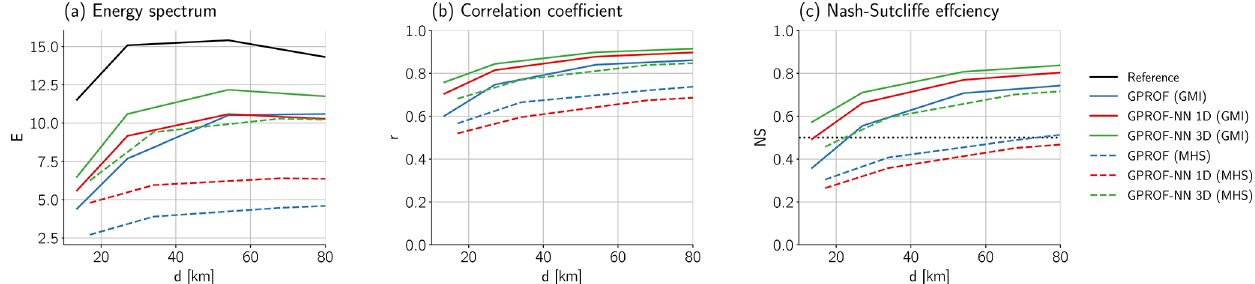
Figure 10. Spatial variability of retrieved and reference fields. Panel (a) shows the average of the total energy defined as the sum of the squared wavelet coefficients at different length scales for the reference and retrieved surface precipitation fields. Panel (b) shows the correlation coefficient between the coefficients of the reference and the retrieved precipitation field. Panel (c) shows the corresponding Nash–Sutcliffe